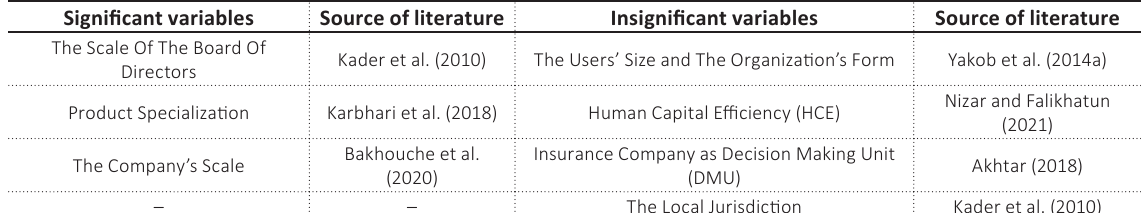
Table 7. Influence of variables on